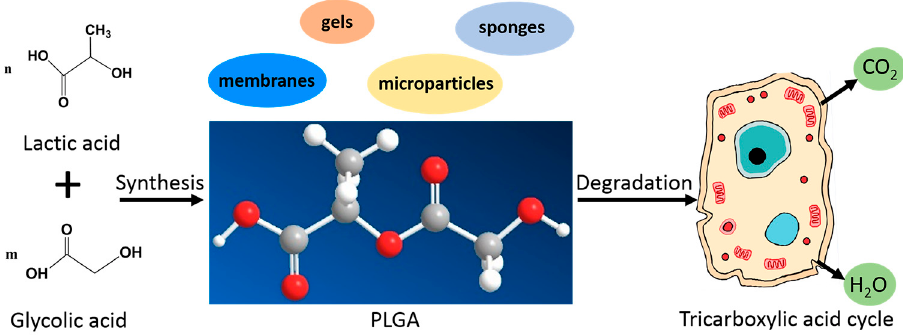
Figure 2. Synthesis, chemical structure, formulation and degradation of PLGA.